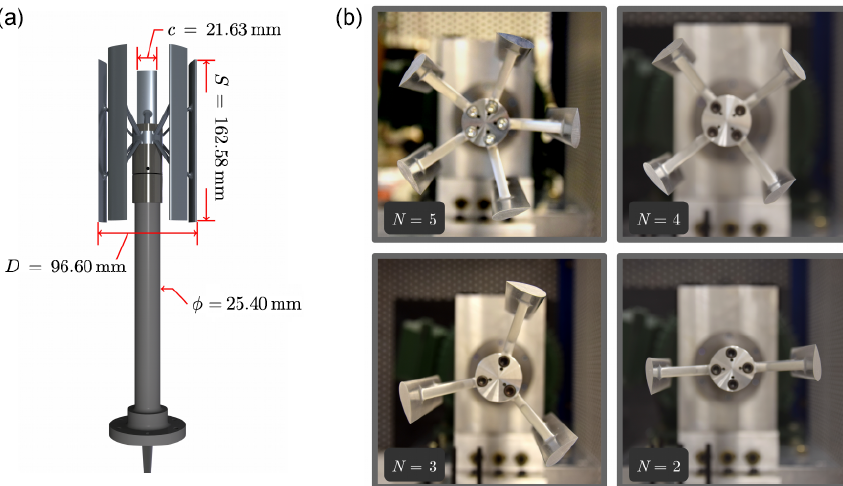
Figure 4. (a) Five-bladed VAWT model with dimensions. (b) Top-down view of all four turbine configurations. The airfoil profile is that of NACA-0021 in all models.